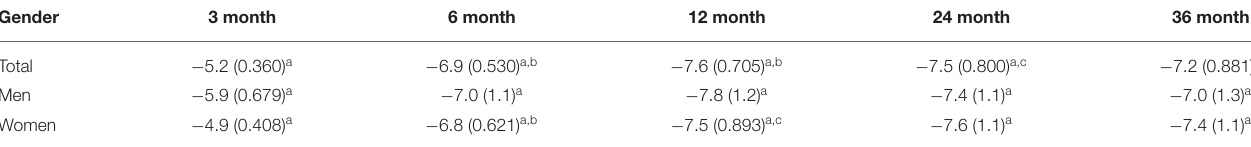
TABLE 4 | Adjusted weight change (kg) from